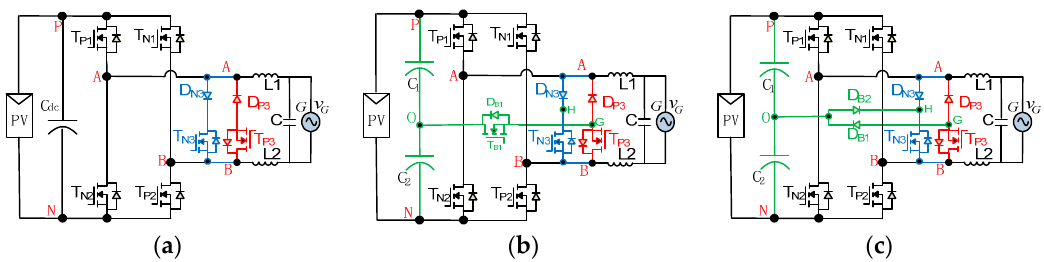
Figure 7. Indirect Connection NPC topologies R1S1 under M = 2, N = 2. ( a ) HERIC topology R1; ( b ) R1S1-1; ( c ) R1S1-2 [50,51].